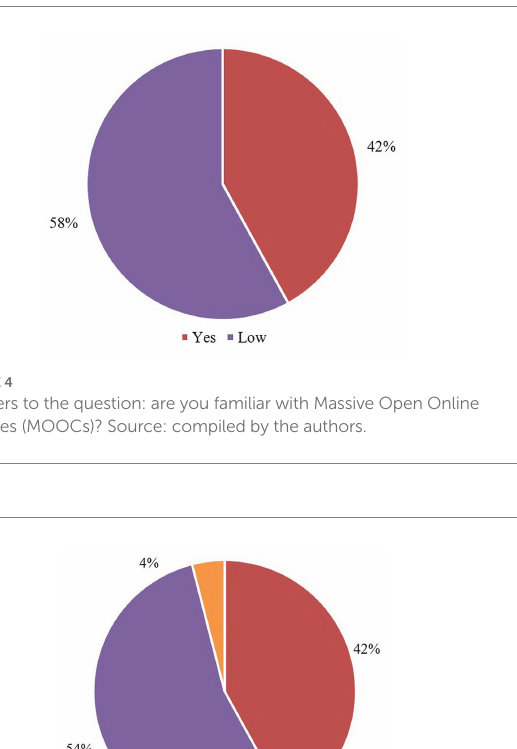
FIGURE 8 Answers to the question: please, rate the development of your technical competence (Post-training survey). Source: compiled by the authors.